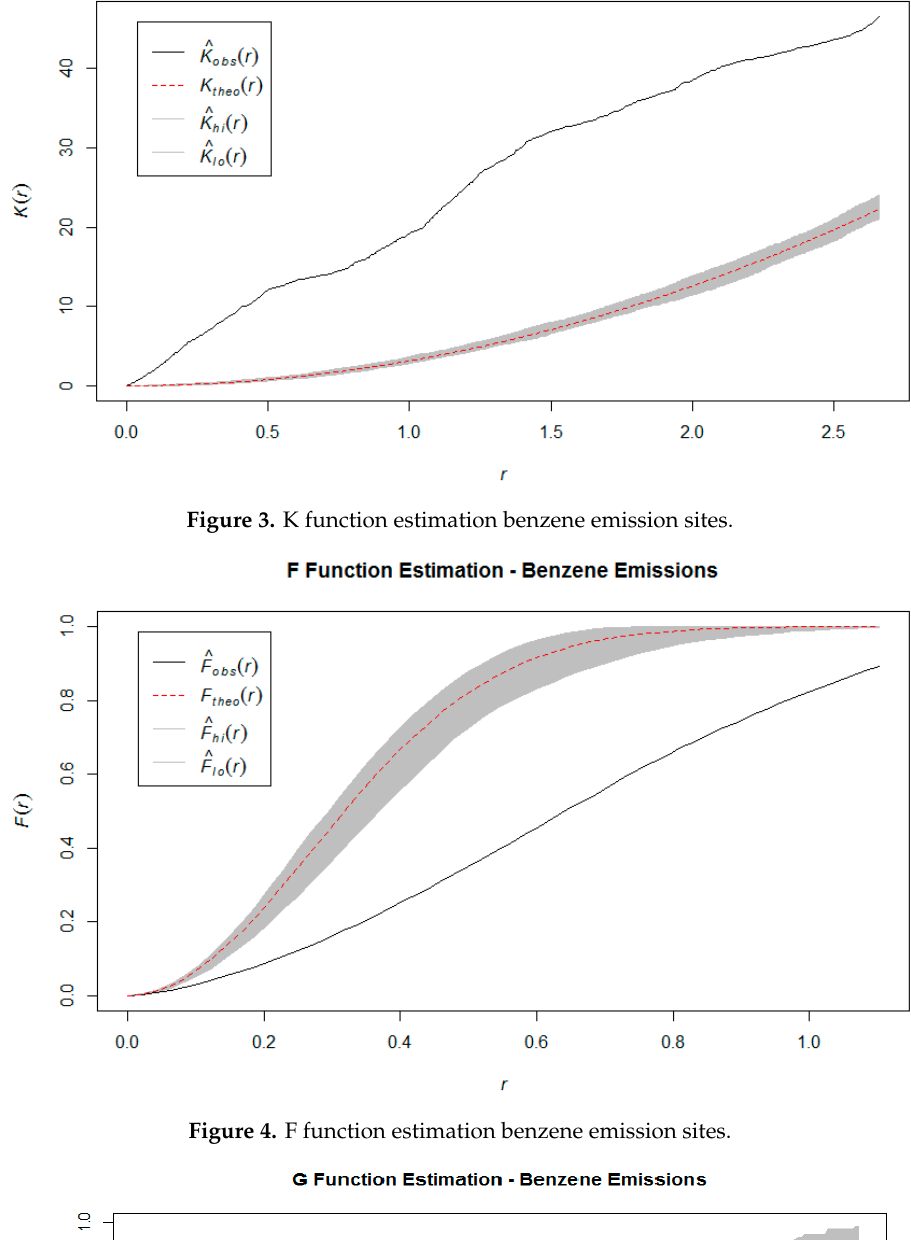
Figure 4. F function estimation benzene emission sites.